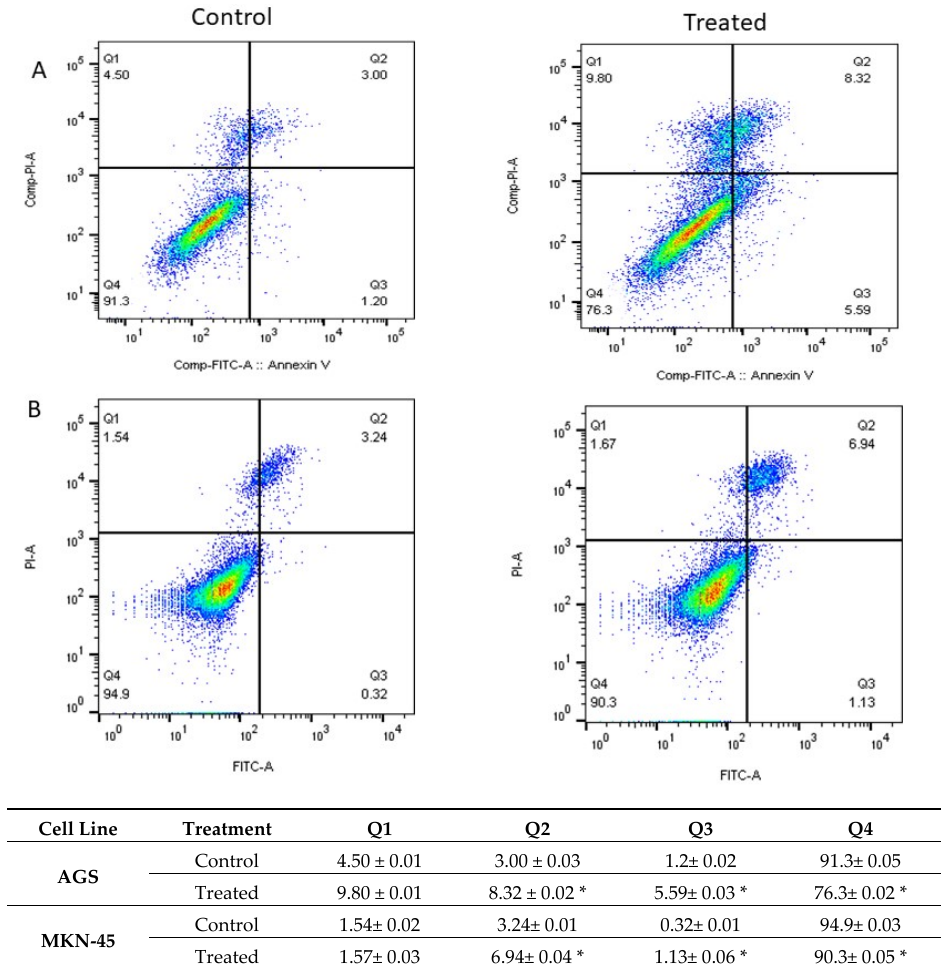
Figure 3. The level of apoptosis and necrosis was assessed by flow cytometry in ( A ) AGS and ( B ) MKN-45 cells, using Annexin V/PI staining. The control groups were without any treatment, and the treated group was treated with 20 and 25 µg/mL carnosic acid in AGS and MKN-45 cell lines, respectively for 24 h. Q1, Q2, Q3, and Q4 represent necrotic cells, late apoptotic, early apoptotic, and living cells, respectively. * p < 0.001.